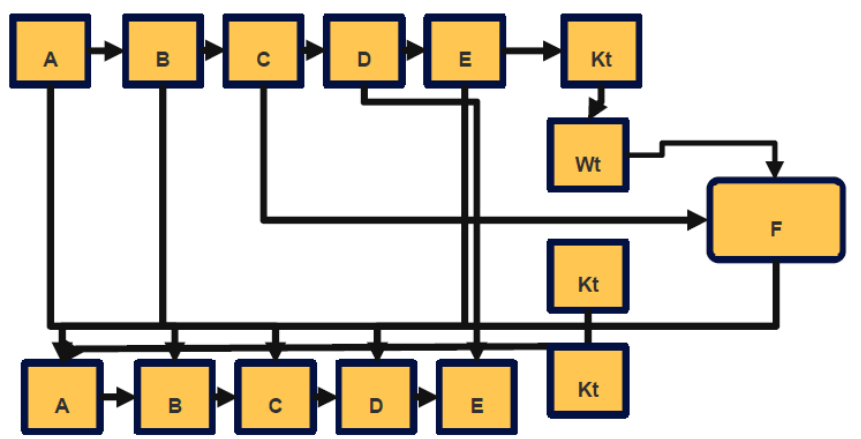
Figure 7. SHA compression function.